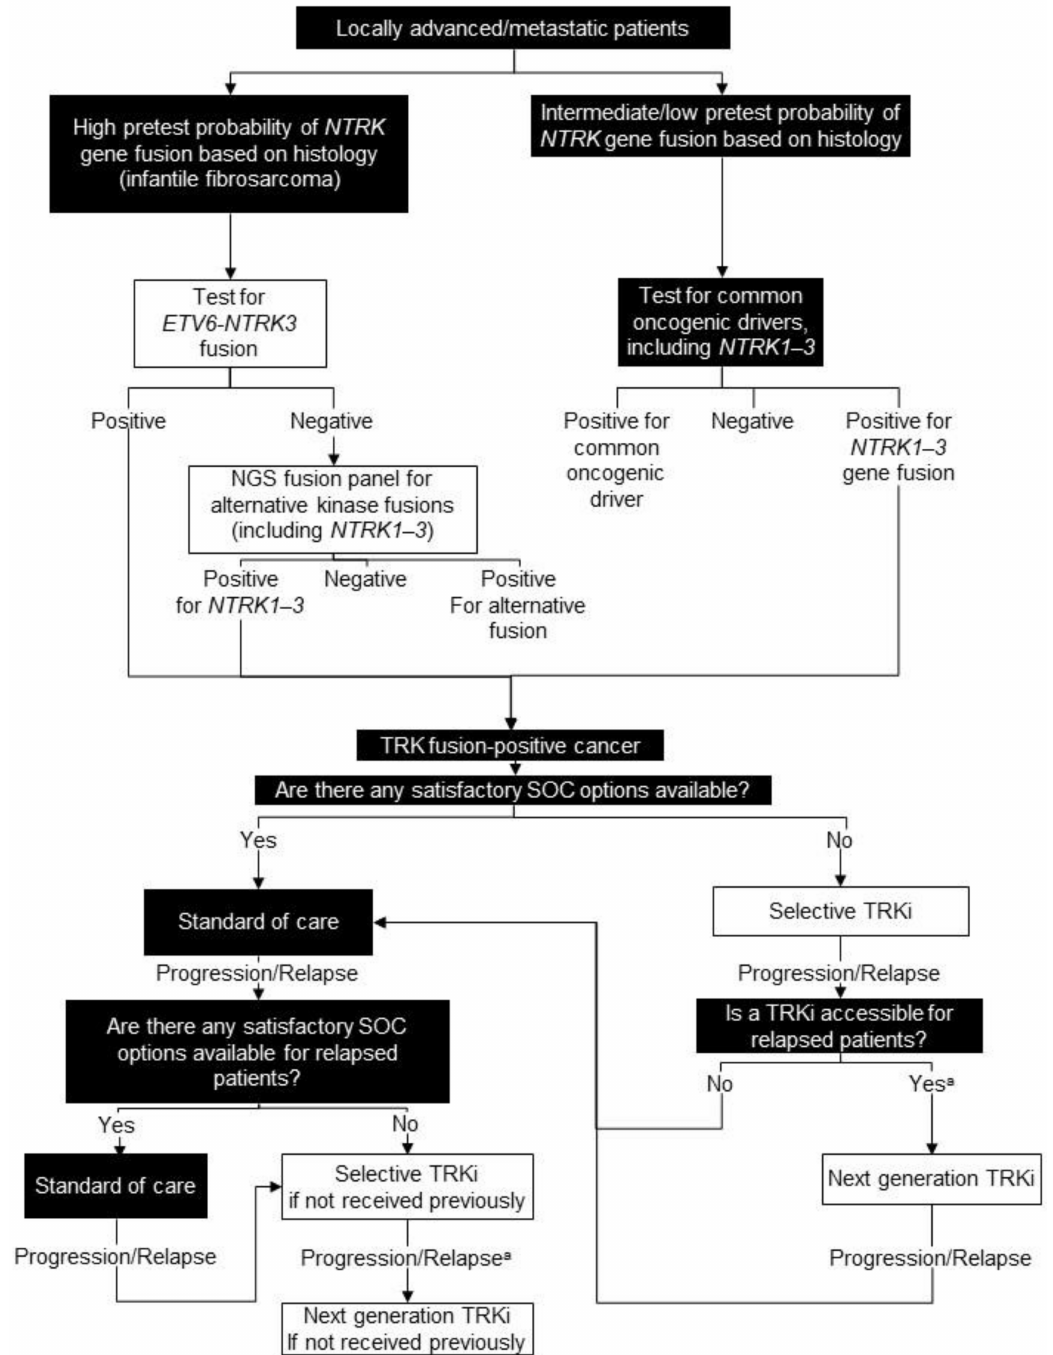
Figure 4. Biomarker testing and treatment for neurotrophic tyrosine receptor kinase ( NTRK ) gene fusions. White boxes with black outlines represent either NTRK gene fusion testing or treatment with a TRKi. Black boxes with white text indicate all other steps that do not include either NTRK gene fusion testing or treatment with a TRKi. a Consider re-biopsy and molecular test to confirm acquired resistance mutation. NGS = next generation sequencing; SOC = standard of care; TRK = tyrosine receptor kinase; TRKi = TRK